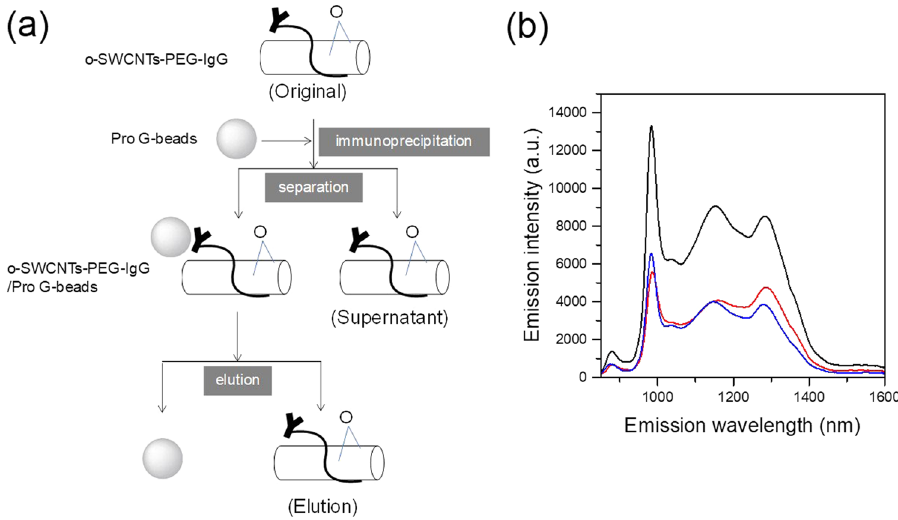
Figure 2. ( a ) Flow chart of our immunoassay experiment. ( b ) PL spectra of original (black), supernatant (red), and elution (blue) of o-SWCNTs. Excitation wavelength = 570